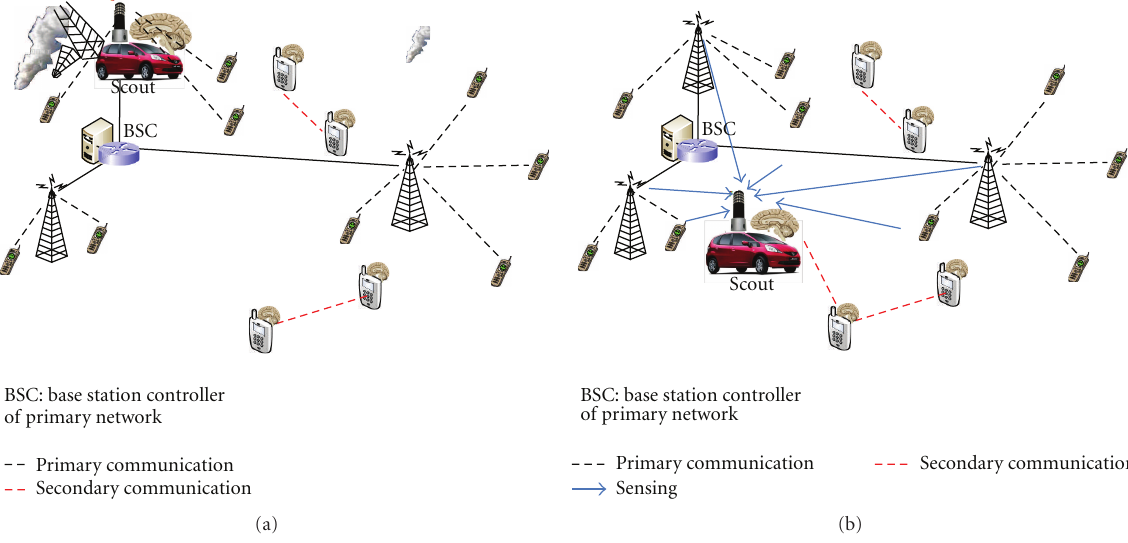
Figure 3: Scout in (a) altruistic primary communication support mode and (b) opportunistic secondary communication